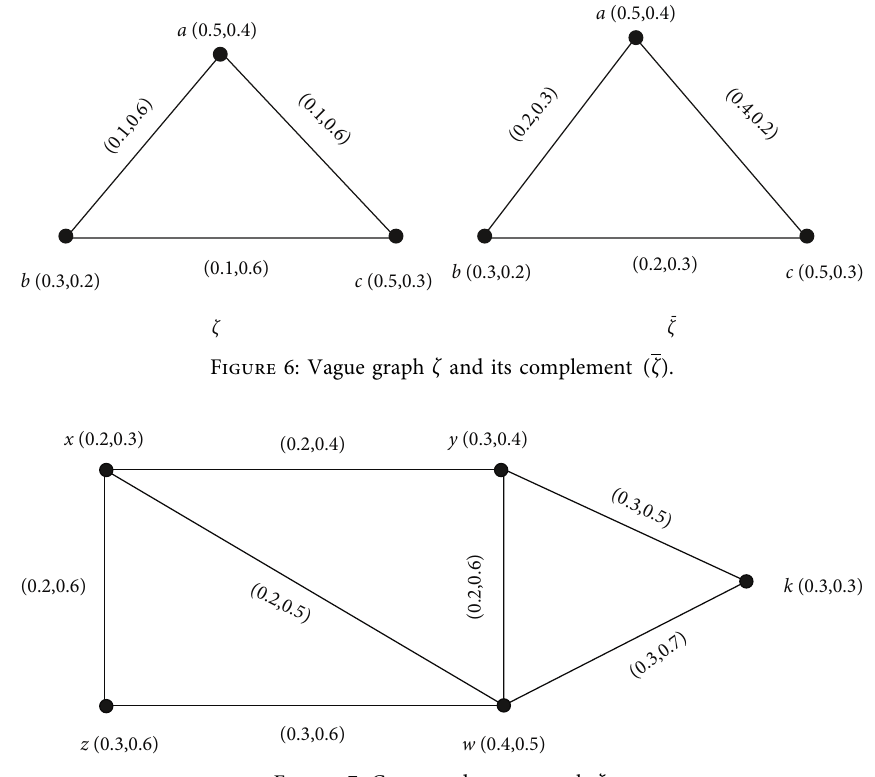
Figure 7: Connected vague graph ζ .